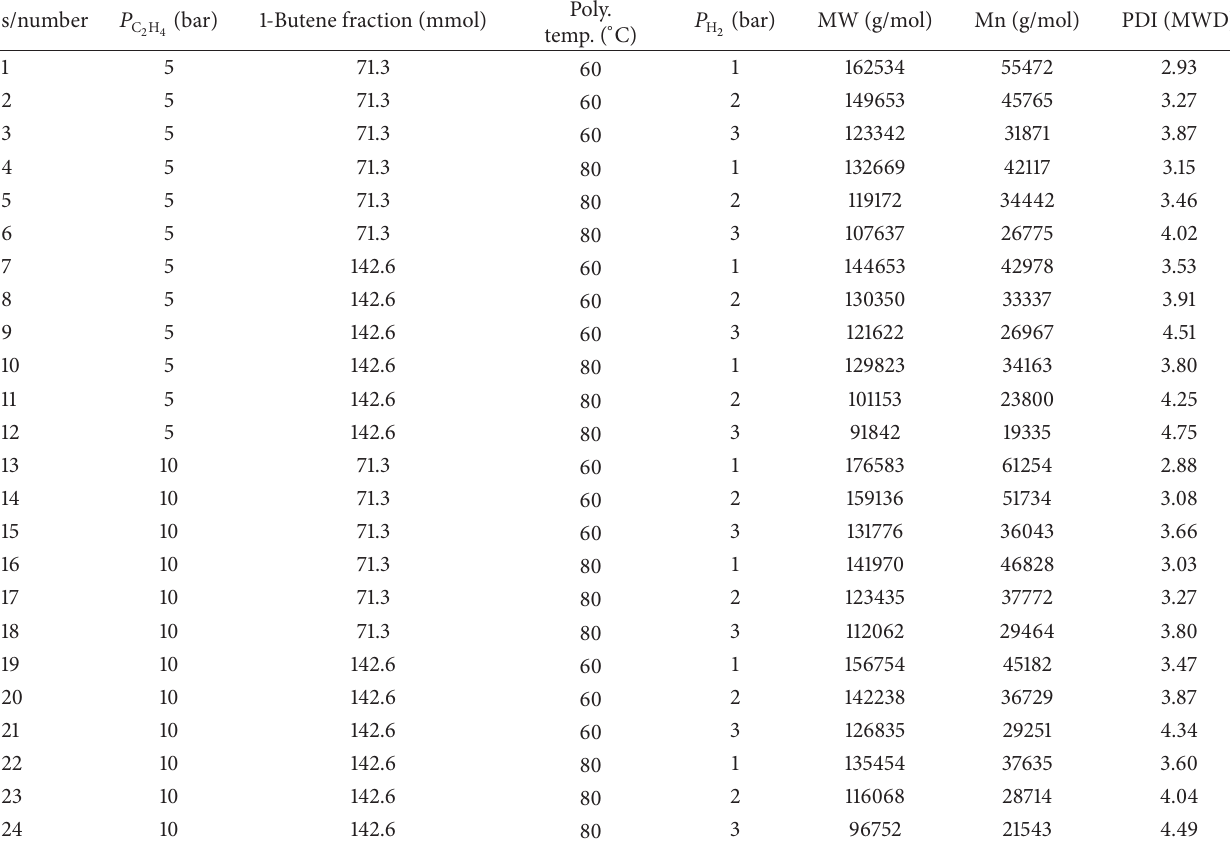
Table 1: Ethylene/1-butene copolymerization data (polymerization time: 30